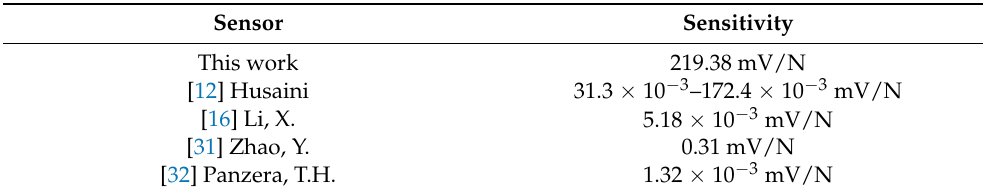
Table 2. Sensitivity comparison of different cutting force sensors.